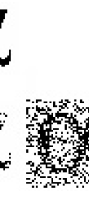
Figure 2. Additive noise, subtractive noise, and mixed noise,